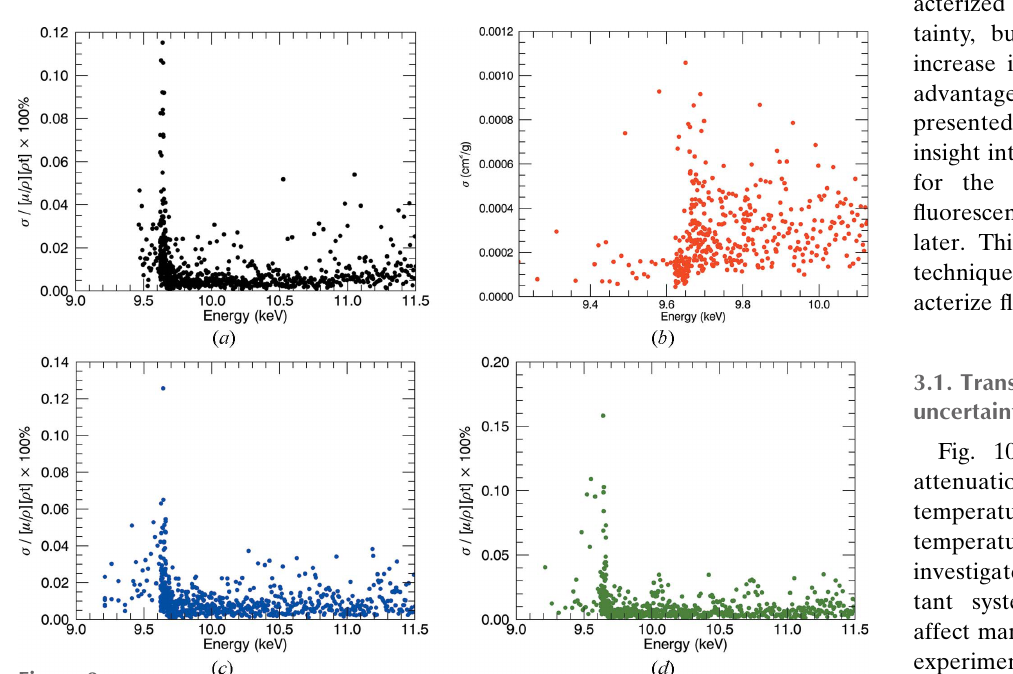
Figure 8 = ½ (cid:3)=(cid:2) (cid:2)½ (cid:2) t (cid:2)g (cid:5) 100 % for ( a ) 10 K, ( b ) 50 K, ( c ) 100 K and ( d ) 150 K. Typical Uncertainties f (cid:4) se uncertainties are below 0.1% at the edge and below 0.03% thereafter, in line with earlier work (Sier et al. , 2020; Ekanayake et al. , , 2021 a , b ).